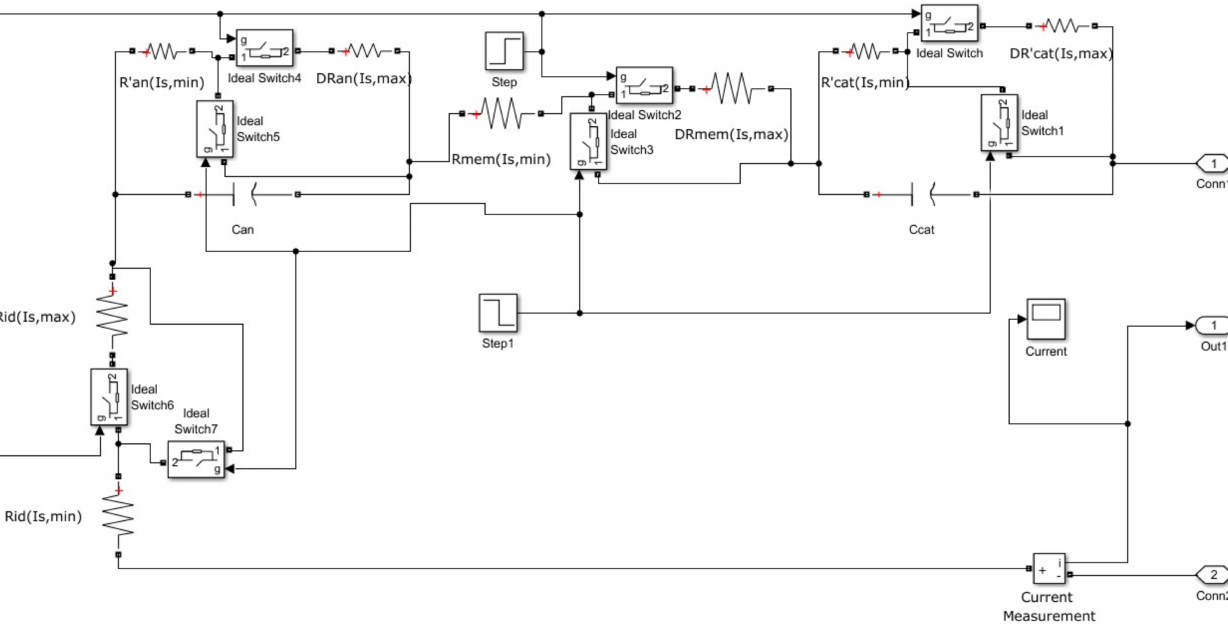
Figure 3. Layout of the PEM electrolytic stack in the Simulink ®